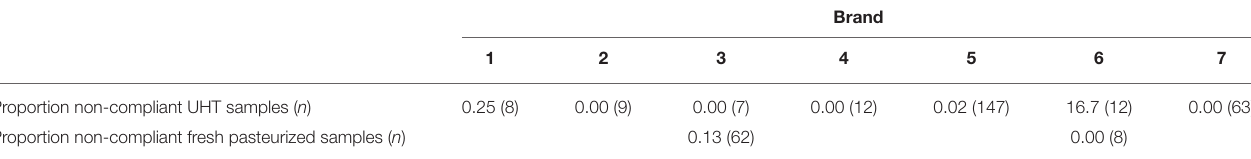
TABLE 1 | Non-compliance by brand and milk type, EAC coliform standard (based on E. aerogenes cfu/ml).